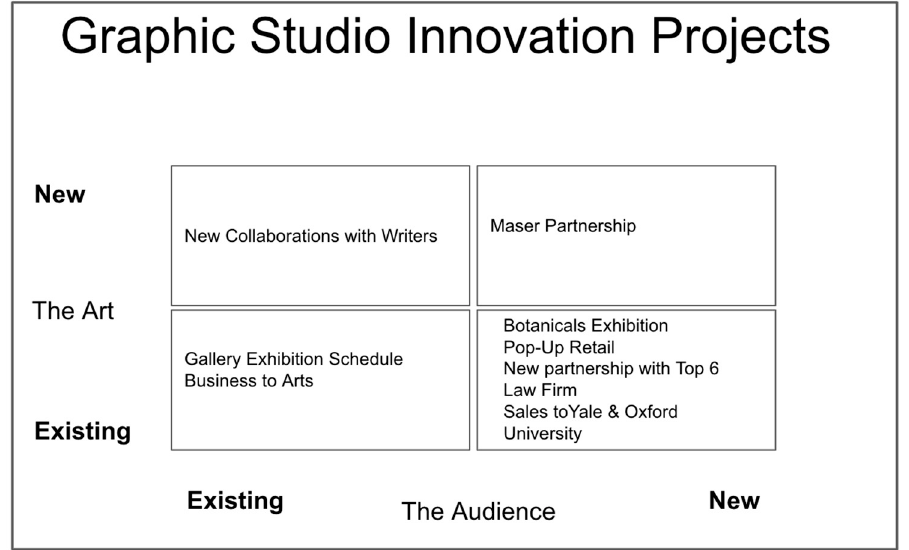
Figure 7. Classification of the Art Thinking projects developed and delivered by the Board.